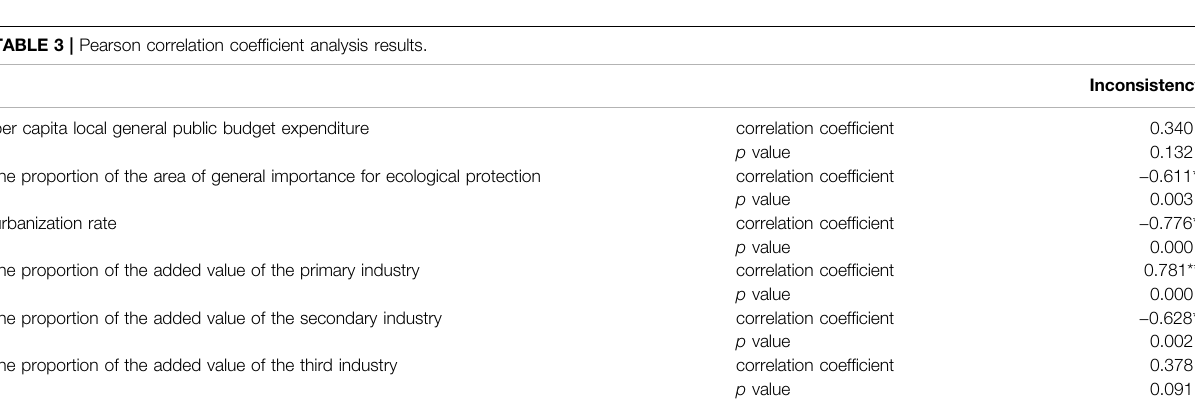
TABLE 3 | Pearson correlation coef fi cient analysis